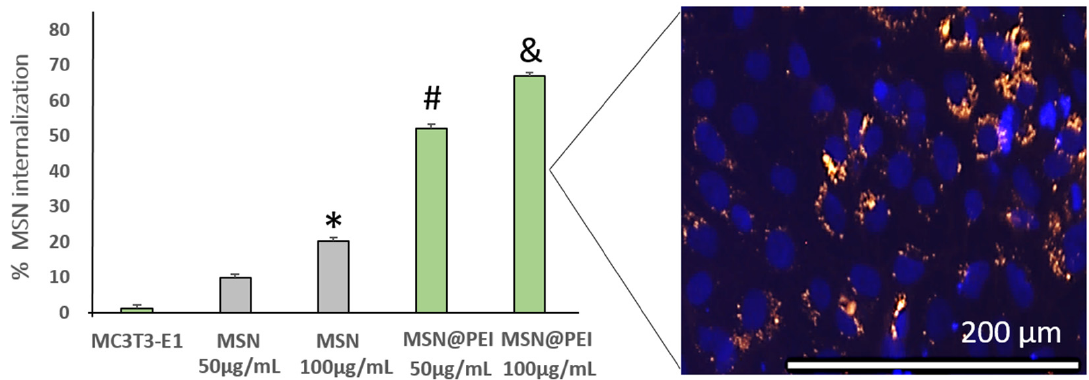
Figure 3. MSN-nanosystem internalization in mouse pre-osteoblastic MC3T3-E1 cells by flow cy- tometry and fluorescence microscopy. Cellular uptake of different Rhodamine-B-labeled MSNs and MSN@PEI was measured at 50 µ g/mL and 100 µ g/mL by flow cytometry at 2 h of internalization in MC3T3-E1 cells. Data are mean ± SEM of three independent experiments performed in triplicate. * p < 0.05 vs. MSN 50 µ g/mL; # p < 0.01 vs. MSNs; & p < 0.05 vs. all groups. Representative images are MC3T3-E1 cells incubated with Rhodamine-B-labeled MSN@PEI at 100 µ g/mL. Blue fluorescence (nuclei) and red fluorescence (Rh-MSN@PEI).